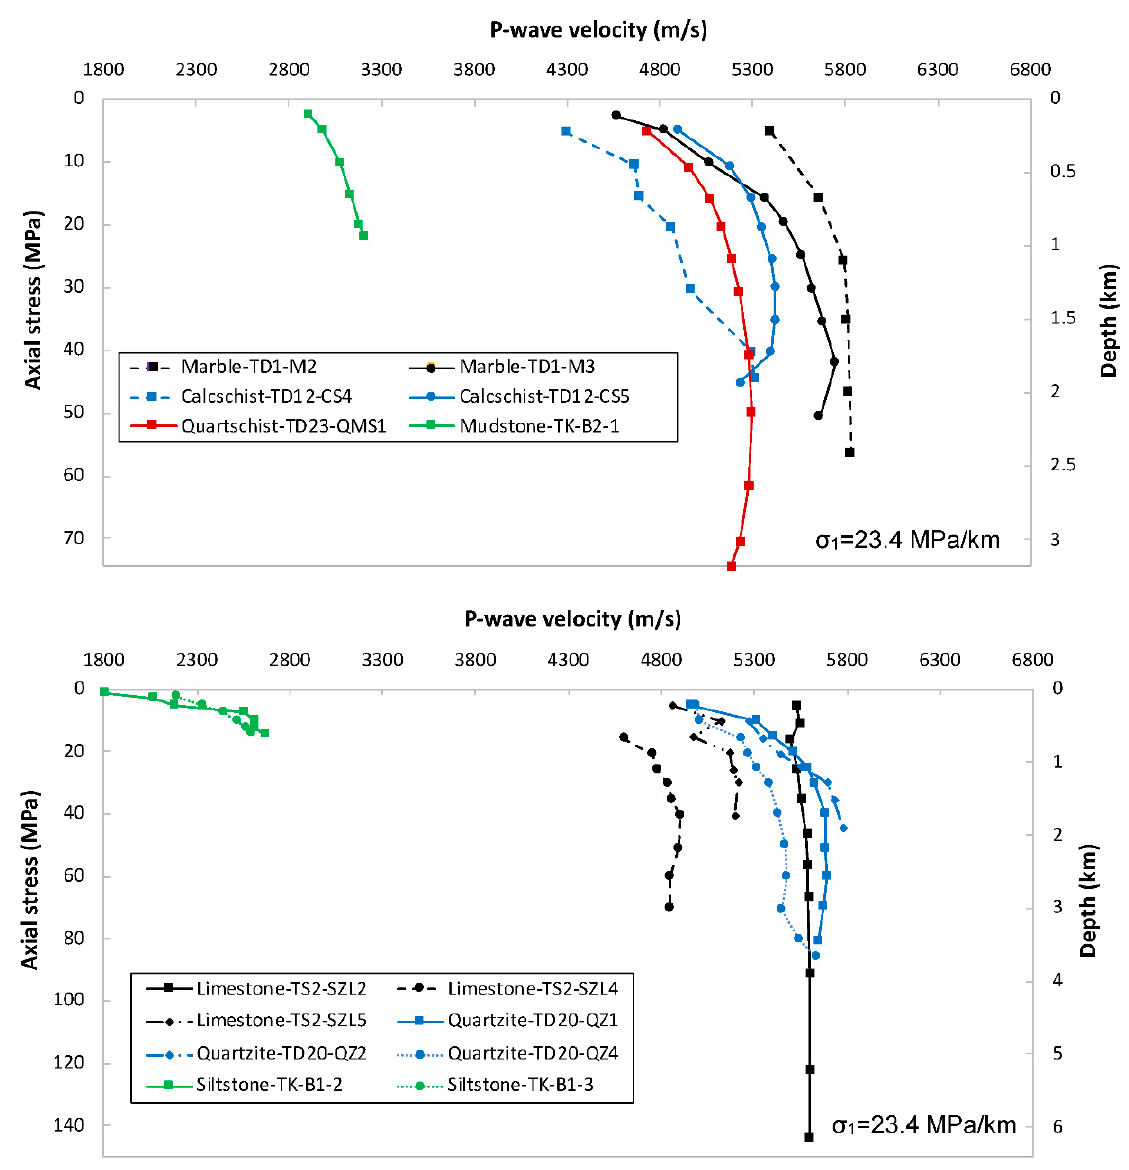
Figure 5. P-wave velocity as a function of axial stress, and thus depth below surface, for all UCS experiments performed. Axial stress–depth relationship is taken from [35].